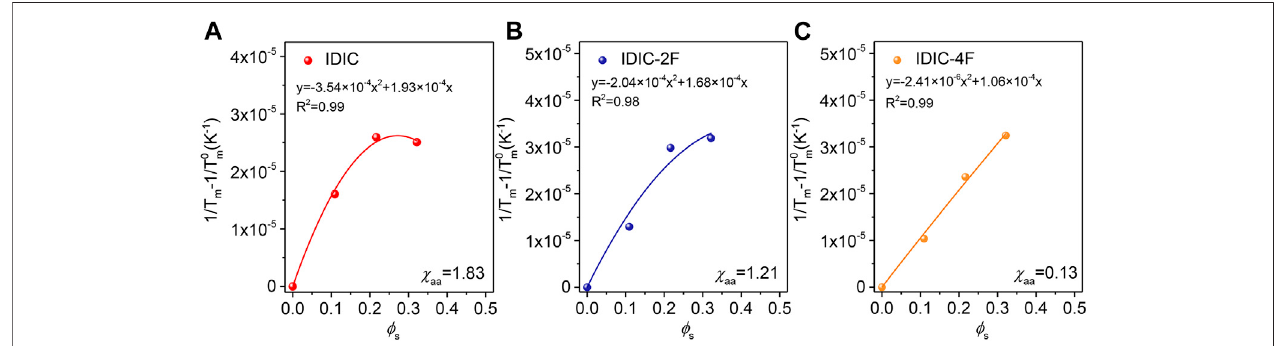
FIGURE6| Measurementsofmeltingpoint depressiontoestimate themiscibilityofPDCBT-Cl:IDIC-xFblends asafunctionofthevolume fraction ofacceptors (A) IDIC (B) IDIC-2F (C)